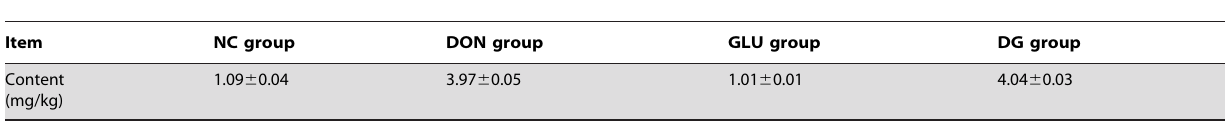
Table 1. Deoxynivalenol content in different dietary groups.